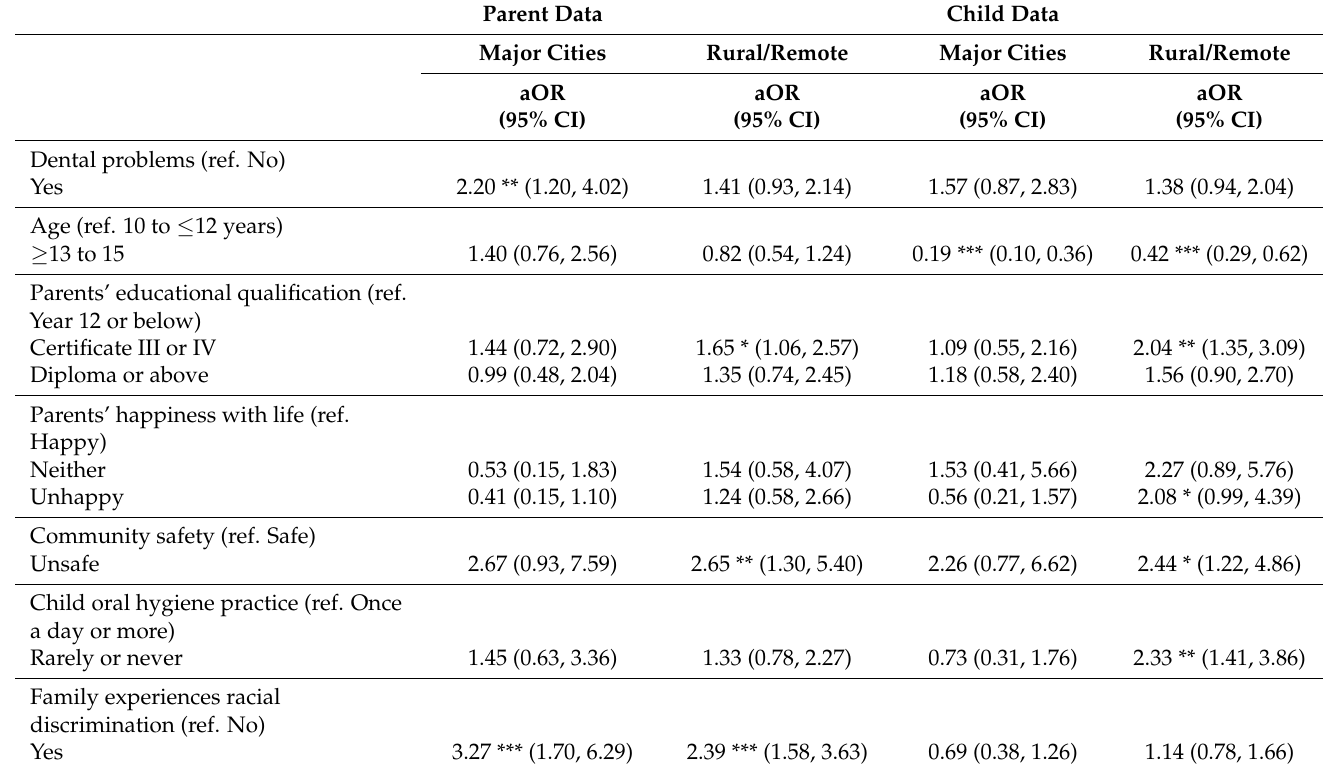
Table 5. Logistic models for bullying